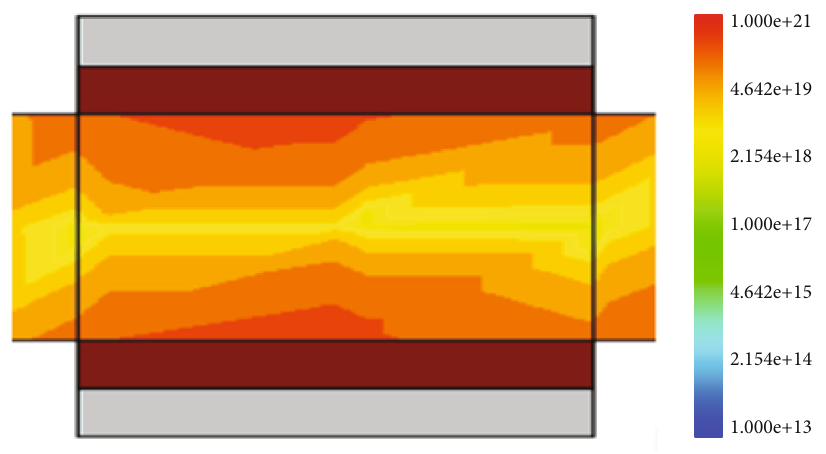
Figure 2: Electrostatic potential within the